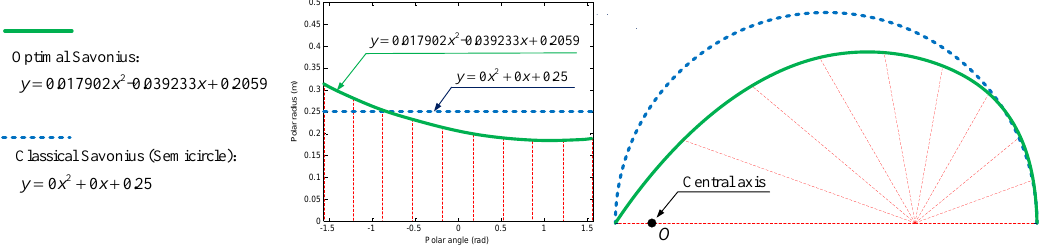
Figure 14. Comparison of the shape for the Classical Savonius and the Optimal Savonius.